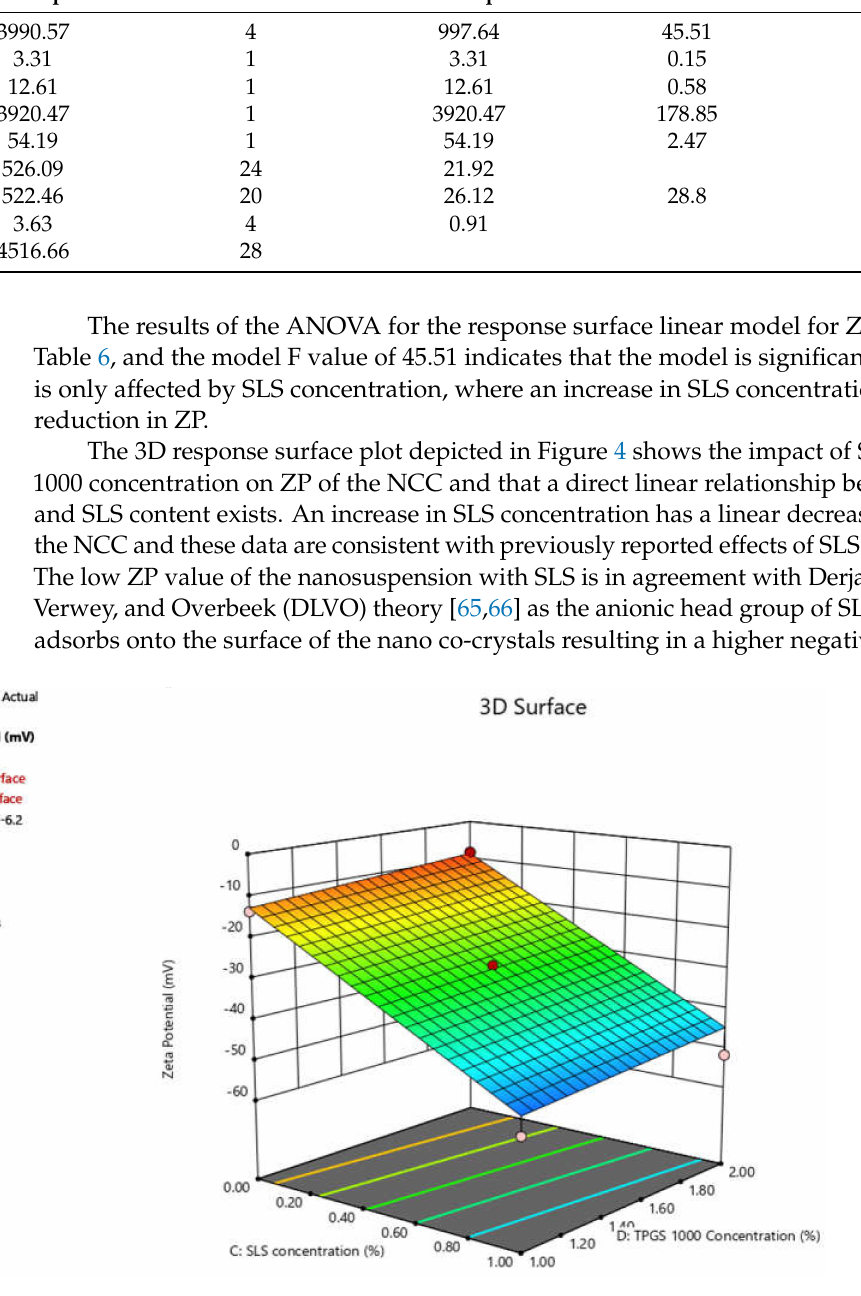
Figure 4. 3D response surface plot depicting the impact of TPGS 1000 and SLS concentration on the ZP of the